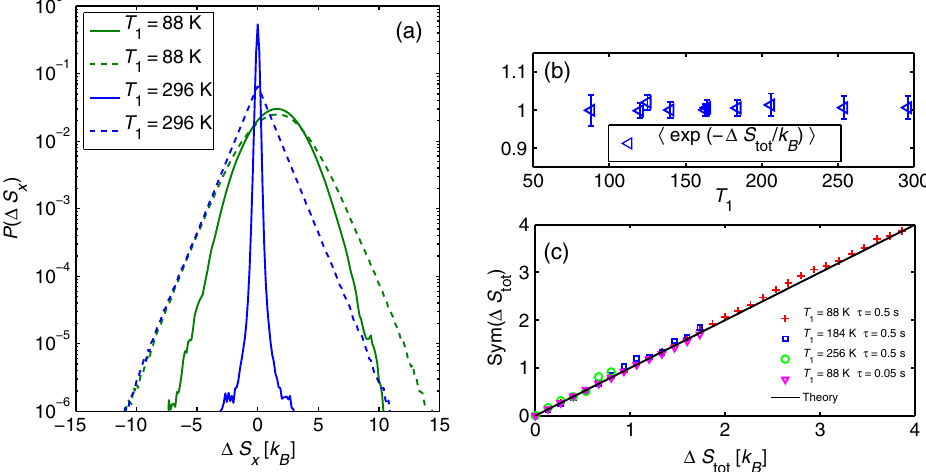
Þ (dashed lines) and P ð Δ S Þ (continuous lines) measured at T ¼ 296 K (blue line) which 1 r tot Þi as a function of T τ ¼ 0 . 5 s 1 at two different tot Þ ¼ log ½ P ð Δ S Þ =P ð − Δ S Þ(cid:2) as a function of Δ S . The black straight line of slope 1 tot tot tot tot